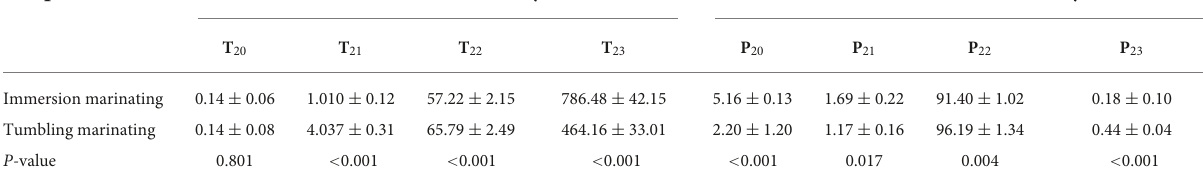
TABLE 2 Effect of vacuum tumbling and immersion marination on water mobility and distribution of chicken breast. Samples